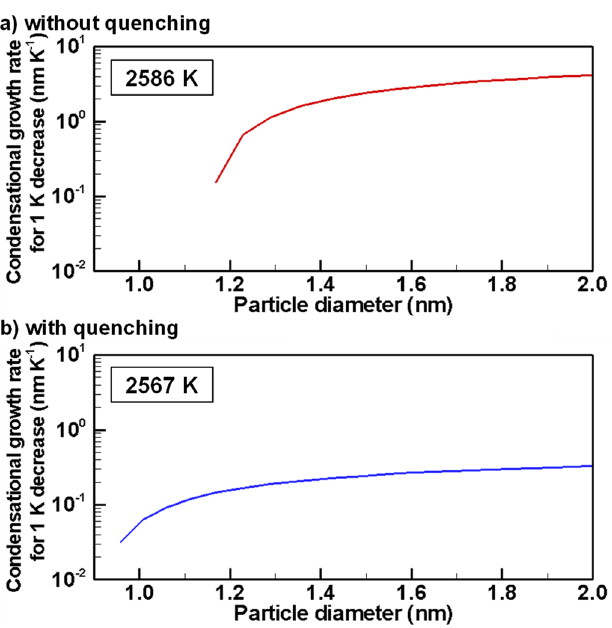
Figure 11. Instantaneous growth rates by heterogeneous condensation at temperatures of the highest homogeneous nucleation rate ( a ) without and ( b ) with quenching.